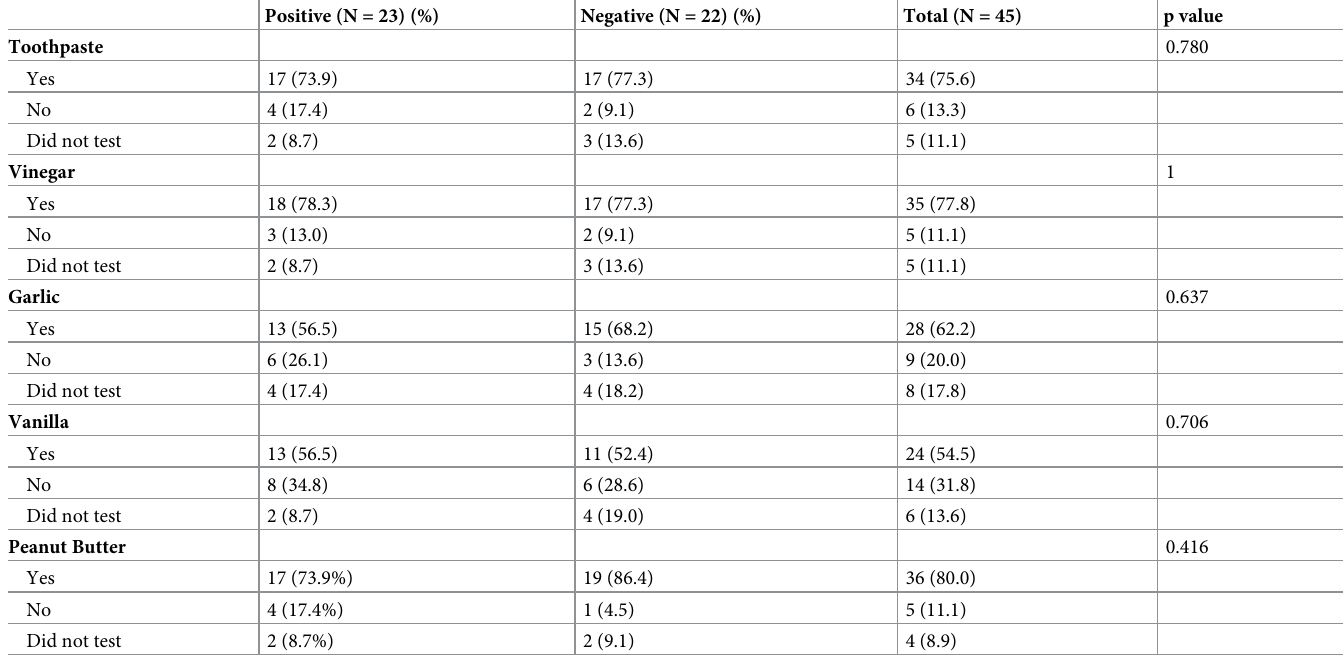
Table 4. Home odorant olfactory testing